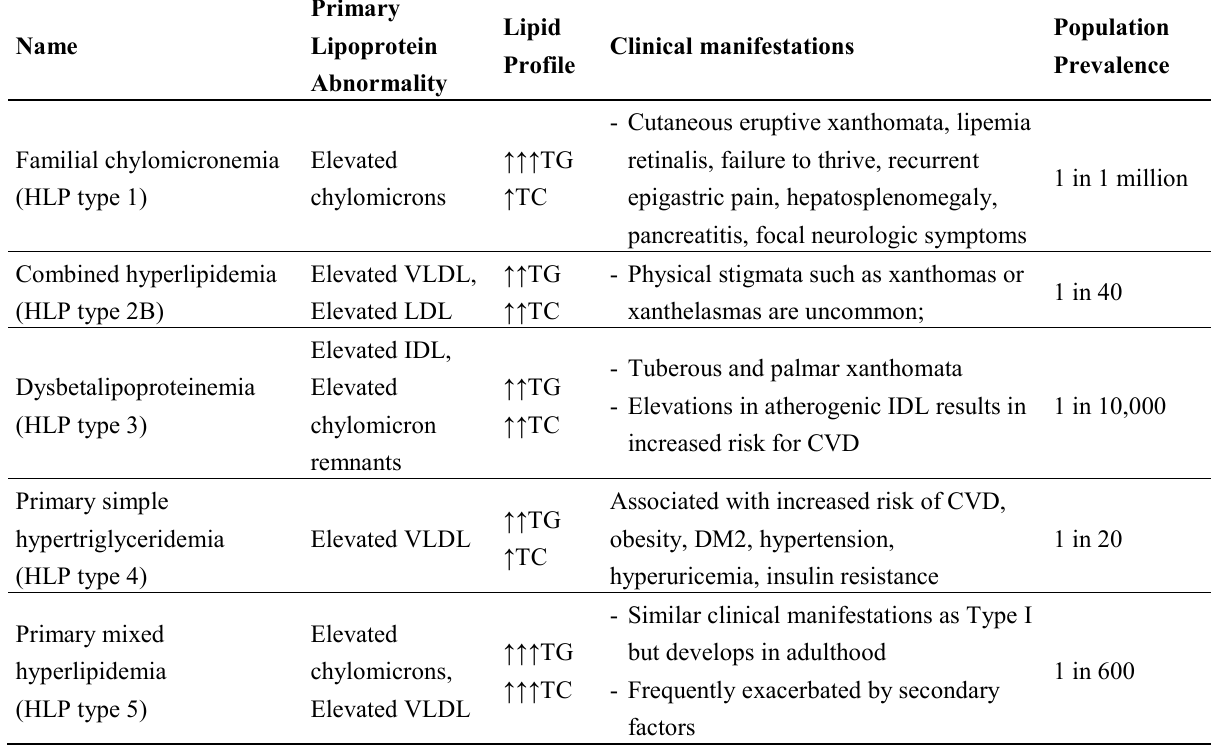
Table 2. Classification of hypertriglyceridemia (modified